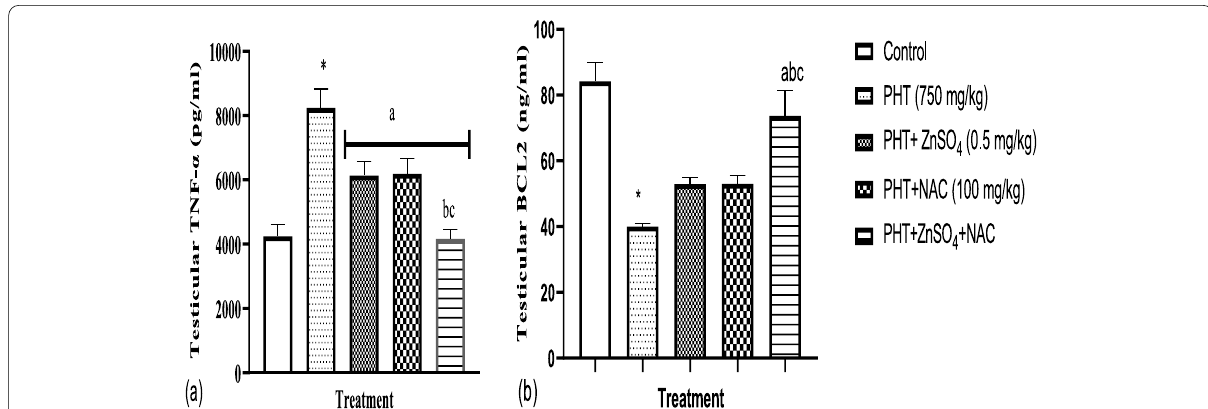
SEM ( n 5) (one‑way ANOVA followed by Tukey’s post ± =